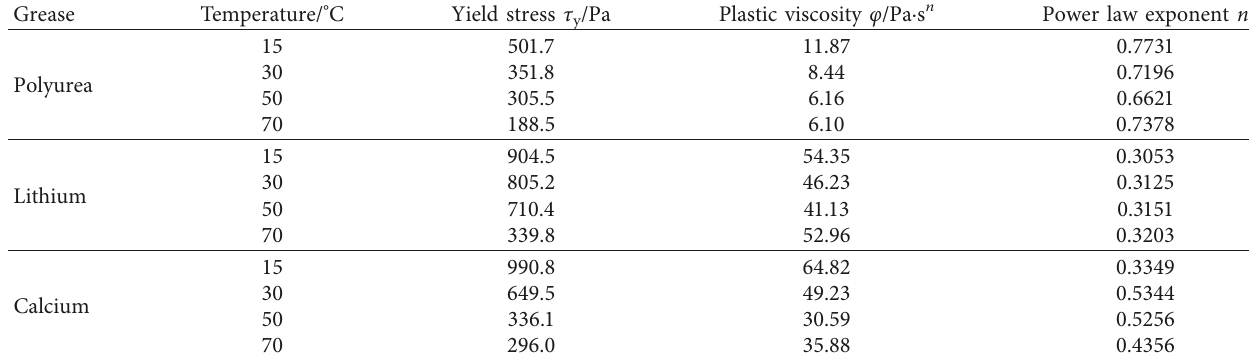
Table 2: Relationships between grease physical properties and temperature